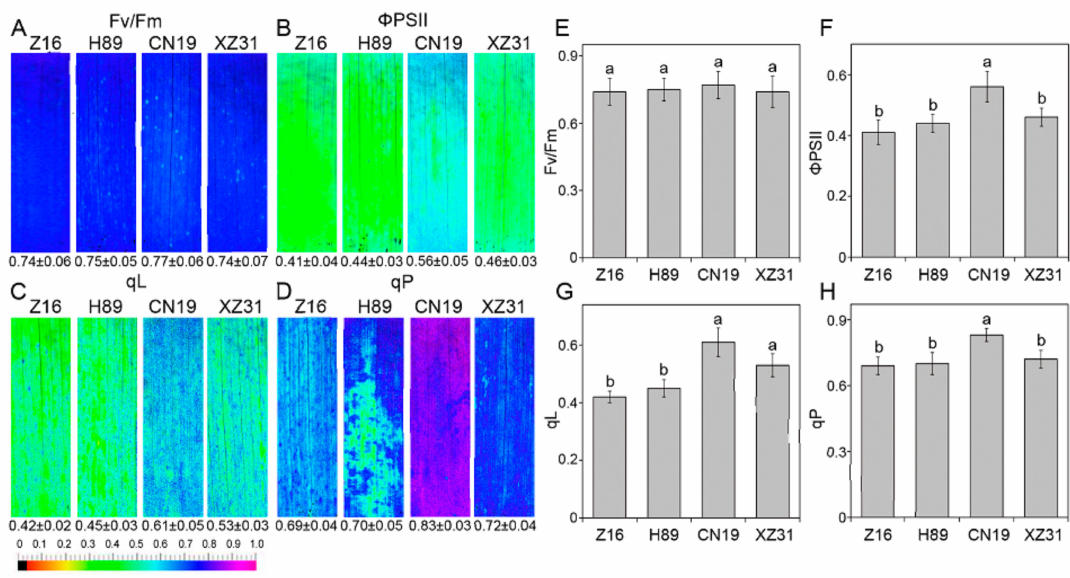
Figure 3. Chlorophyll fluorescence parameters ( Fv / Fm ( A , E ), maximum efficiency of PSII photochemistry; Φ PSII ( B , F ), quantum yield of PSII electron transport; qL ( C , G ), fraction of PSII centers that are open; qP ( D , H ), photochemical quenching coefficient) in Z16, H89, CN19, and XZ31. Representative fluorescence images with quantitative data (±standard deviation) are presented on the left panel. Quantitative values (±SD) from four independent biological replicates are shown on the right panel. Different letters are significant differences at p < 0.05 level (Duncan’s multiple range test). Z16, H89, CN19, and XZ31 present accessions of Triticum monococcum (W2n), Triticum dicoccum (W4n), Triticum aestivum (W6n), and octaploid Triticale (T8n), respectively.